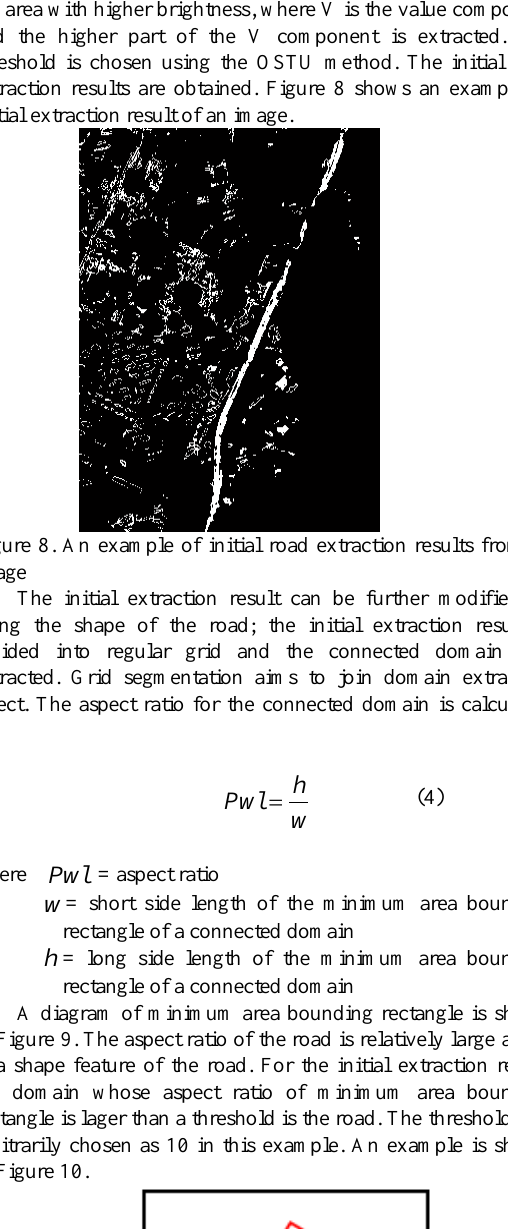
Figure 6. Shadow removal result with different values of n